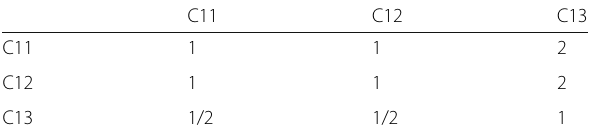
Table 15 The judgment matrix under “ Others ” . (Source: Authors)